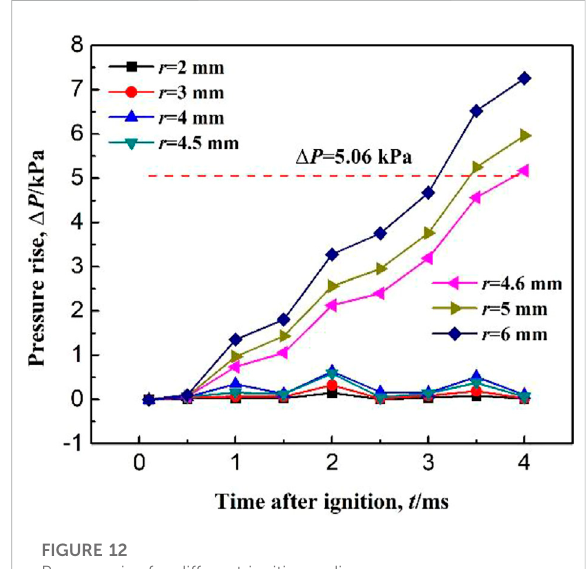
FIGURE 12 Pressure rise for different ignition